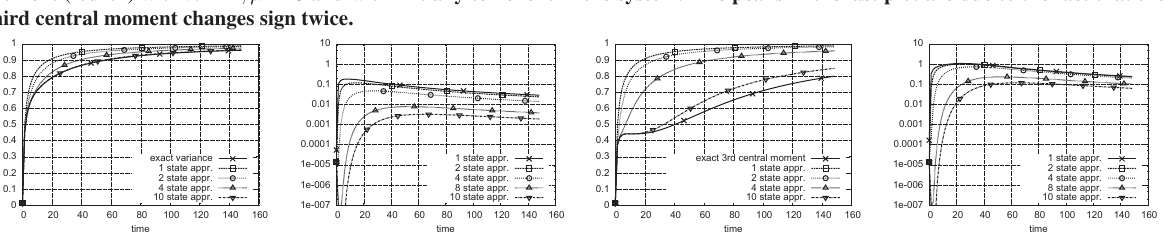
Figure 5: Variance (first plot), relative error of variance (second), third central moment (third) and relative error of the third central moment (fourth) with λ = 1 ,μ = 1 . 5 and with initially empty